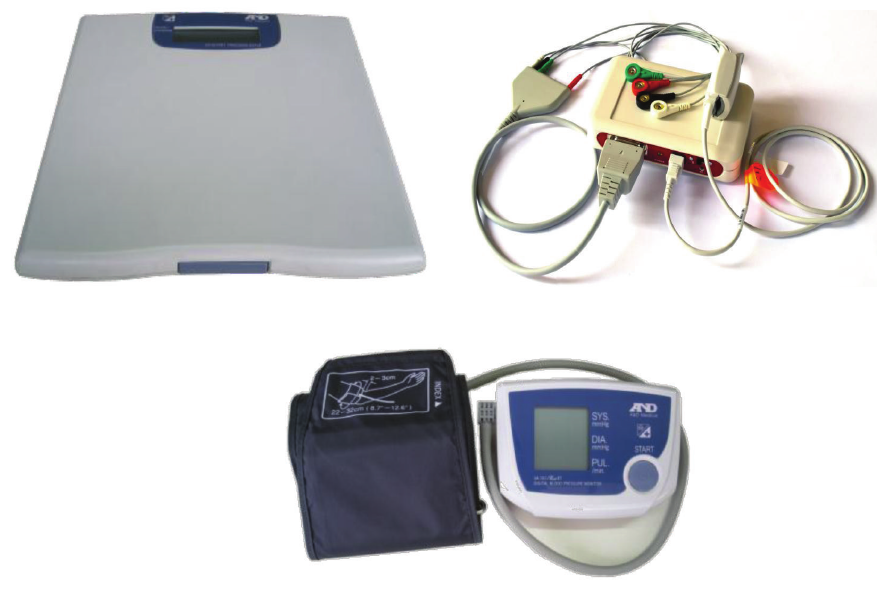
Figure 4: Wireless sensors for the basic version of the H@H